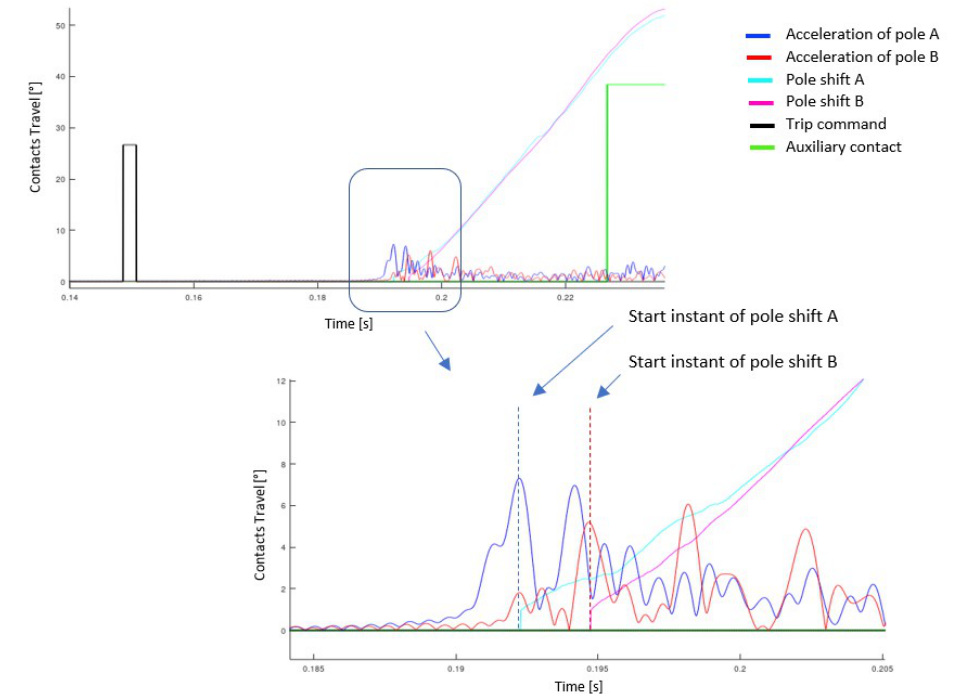
Figure 11. Opening with acceleration